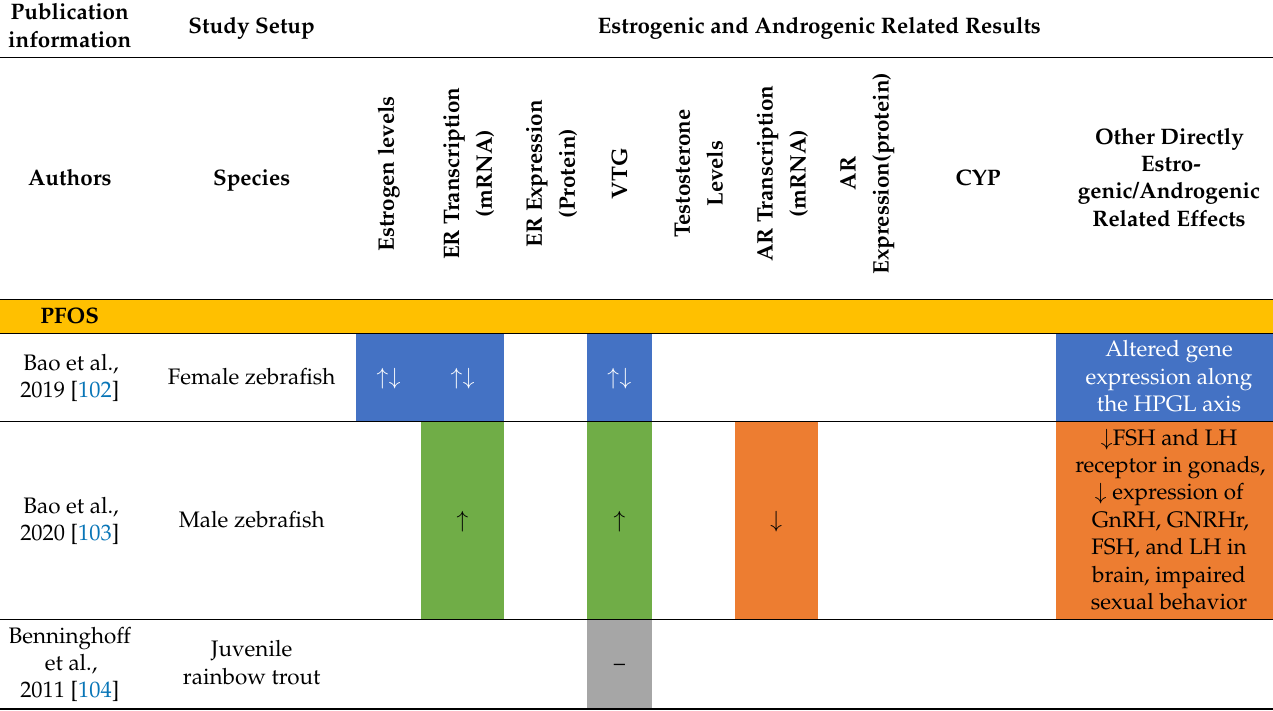
Table 8. In vivo results related to PFAS exposures and estrogen and androgen